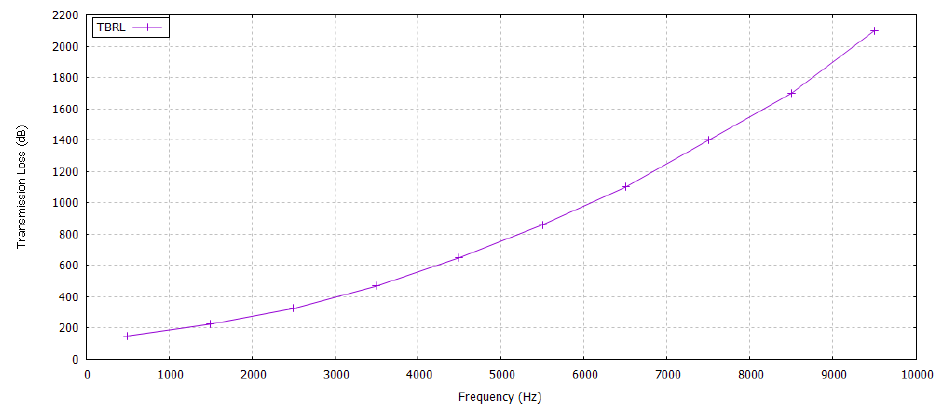
Figure 11. Maximum Transmission Loss in